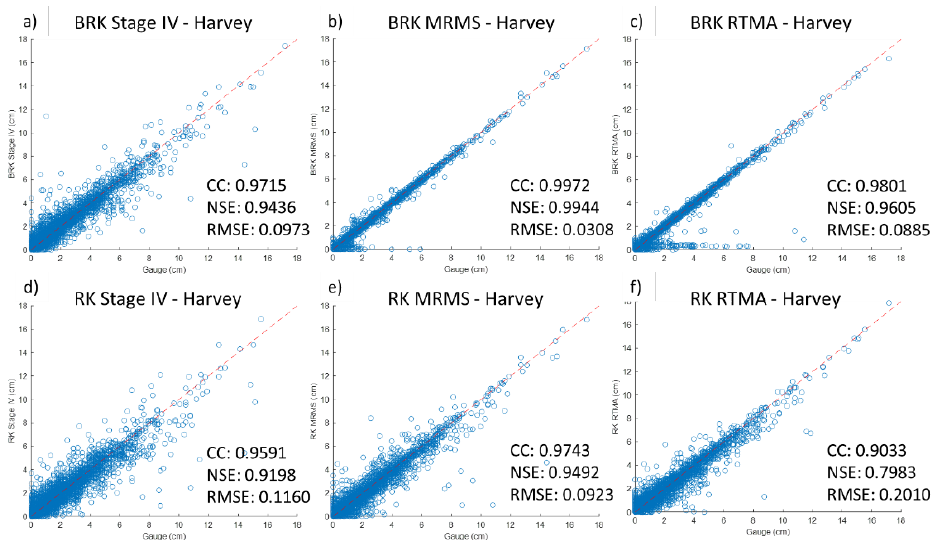
Figure 8. Scatter plots of calibration gauge data and merged radar-gauge data of ( a ) Stage IV, ( b ) MRMS, ( c ) RTMA using the BRK method, ( d ) Stage IV, ( e ) MRMS, and ( f ) RTMA using the RK method during Hurricane Harvey.